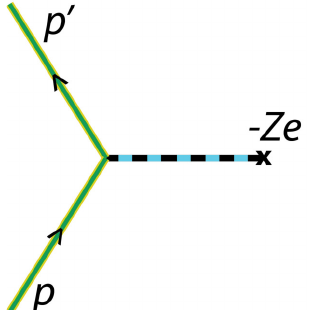
Figure 3. Feynman diagram representing the Mott scattering of an electron with initial and final four-momenta p and p (cid:48) by an infinitely massive (nucleus) of charge − Ze . All particles are on their mass